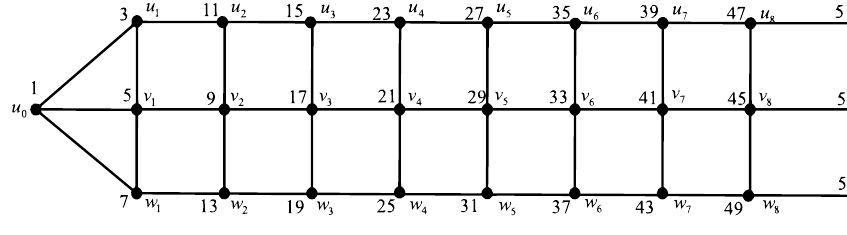
and its odd prime y